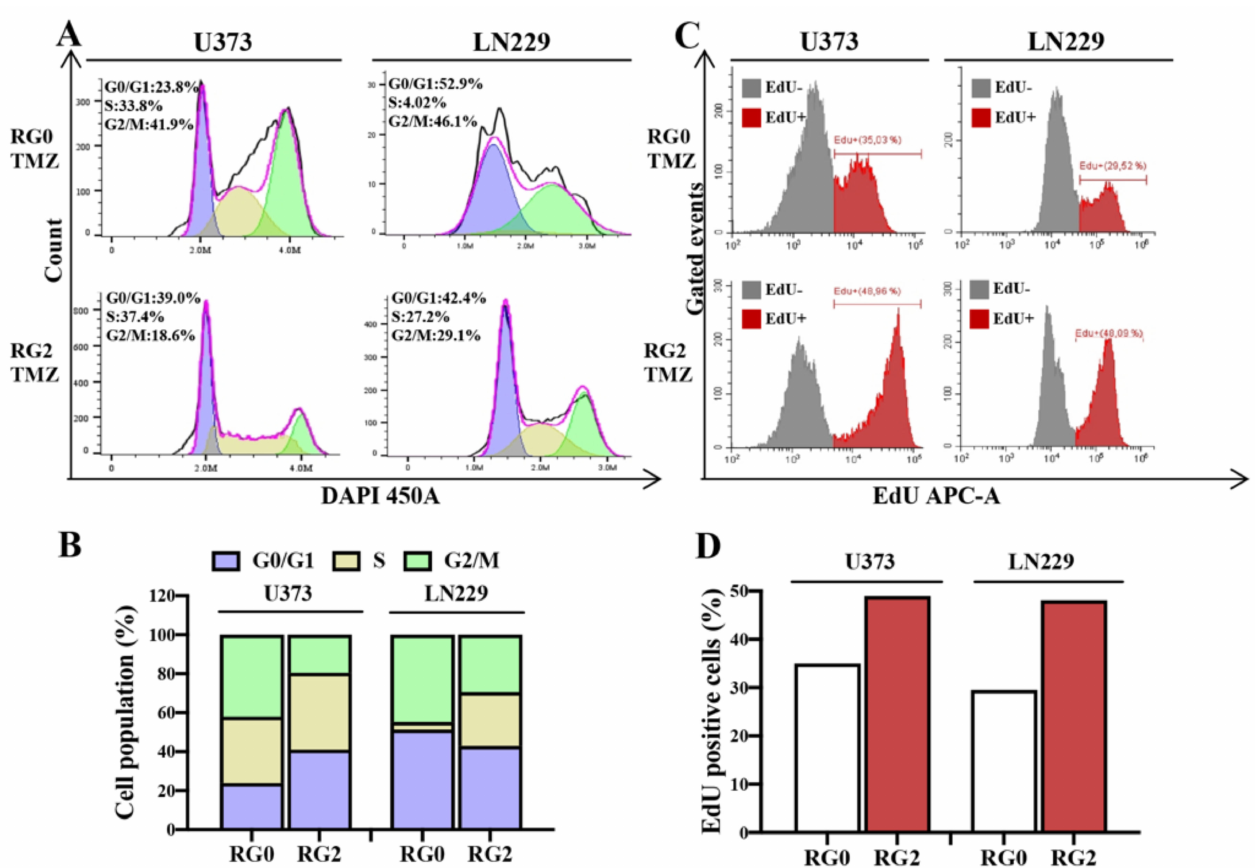
Figure 5. RG2 cells present less G2/M arrest accompanied by an increase in DNA replication after TMZ treatment. Cell cycle ( A , B ) and DNA replication ( C , D ) were detected in U373-RGs and LN229- RGs cells 72 h after TMZ (150 µ M) treatment by flow cytometry. ( A ) Cell cycle histogram. After staining with DAPI, cells underwent flow cytometry assay. Each cell cycle phase is shown in the histogram of DNA contents: G0/1- (purple), S- (yellow) and G2/M phase (green) modeled with the Dean-Jett Fox algorithm. ( B ) Stacked bar graph of cell cycle distributions seen in ( A ). RG2 showed a redistribution in cell cycle compared with RG0. A significantly reduced cell population at the G2/M arrest phase was observed in RG2 of both cell lines after treatment with TMZ. ( C ) Histogram of DNA replication detected by flow cytometry. Two populations of cells—EdU negative (EdU − , grey) and positive (EdU+, red)—were detected after EdU incorporation. ( D ) Bar graph of EdU+/ − populations seen in ( C ). EdU population analysis revealed an increase in DNA replication (EdU+) in RG2 cells compared with RG0 in both cell lines after treatment with TMZ. The data are representative of three independent